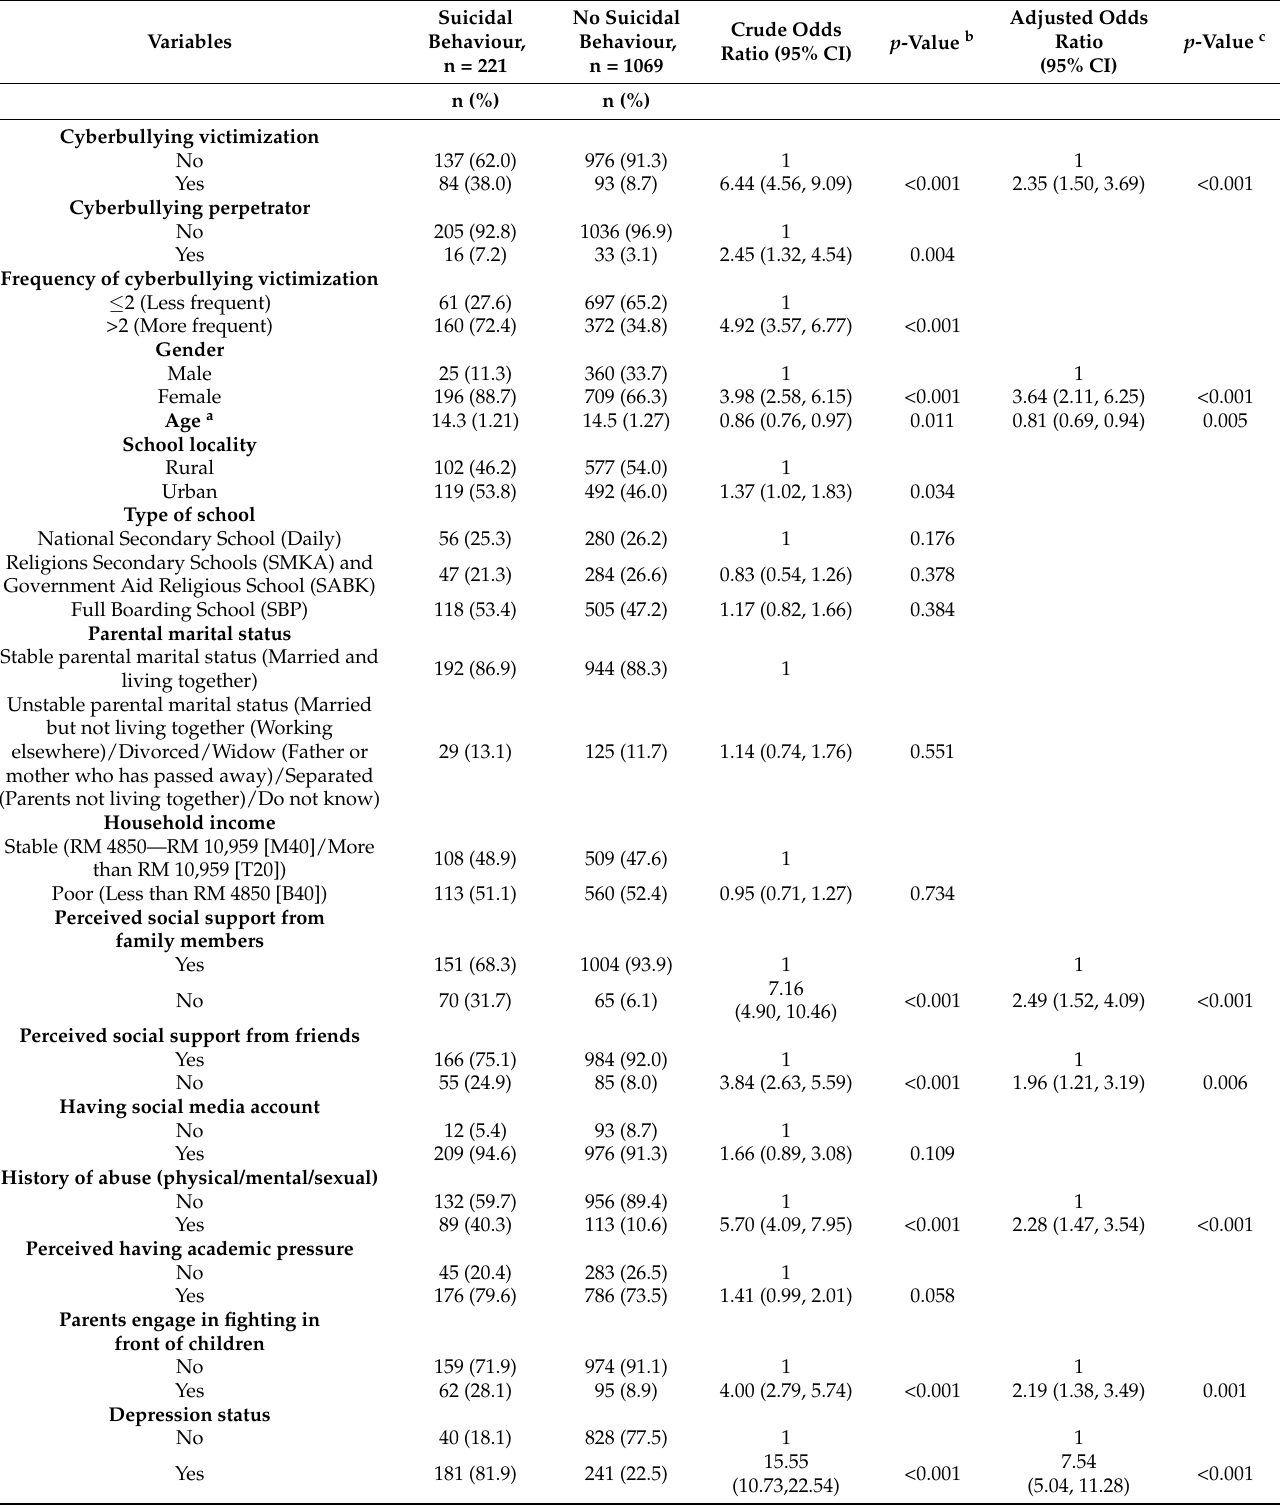
Table 5. The association between cyberbullying and suicidal behaviour among secondary school adolescents in Peninsular Malaysia adjusted for other confounders analysed by simple and multiple logistic regression.